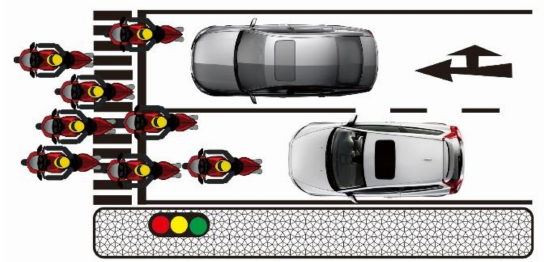
Figure 6. Stop line violation by